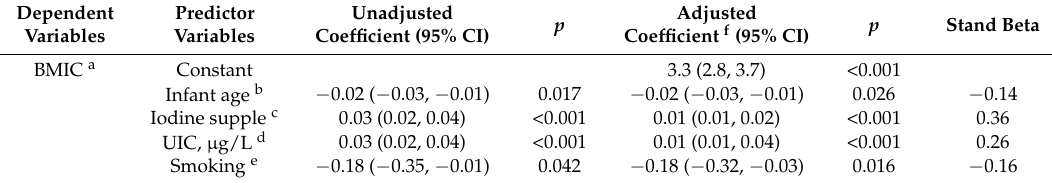
Table 4. Predictors of breastmilk iodine concentration (BMIC) in lactating mothers from Norway ( n = 175). Dependent